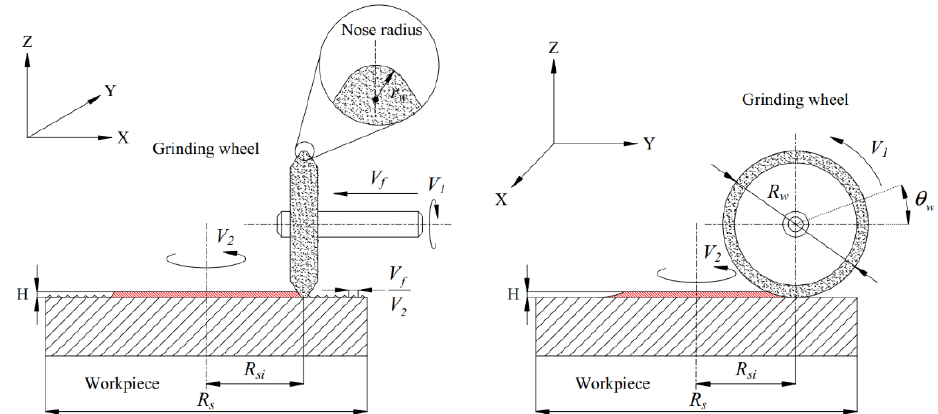
Figure 11. Schematic diagram of precision grinding operation [82]. Reprinted with permission from [82]; 2019 Springer Nature.